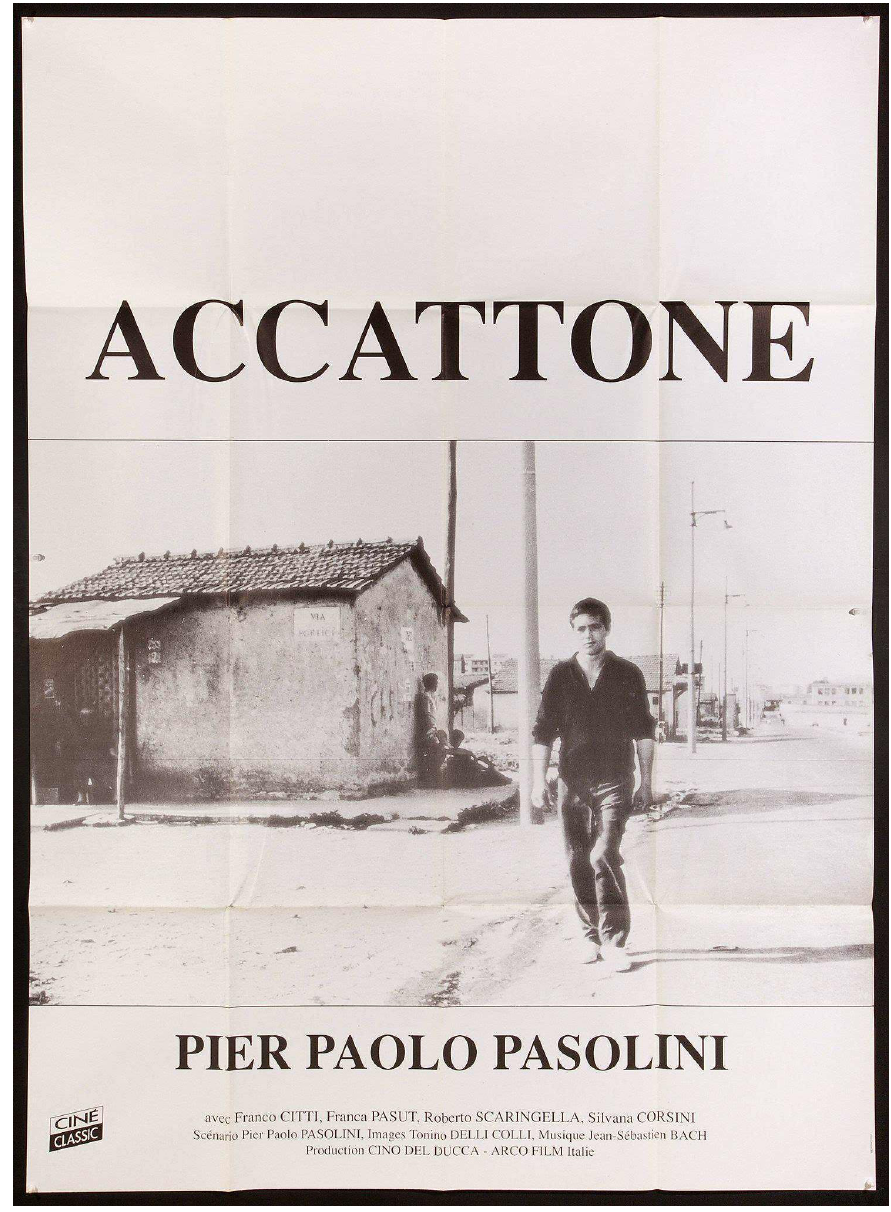
Figure 1. Poster for Pier Paolo Pasolini’s Accattone (1961).